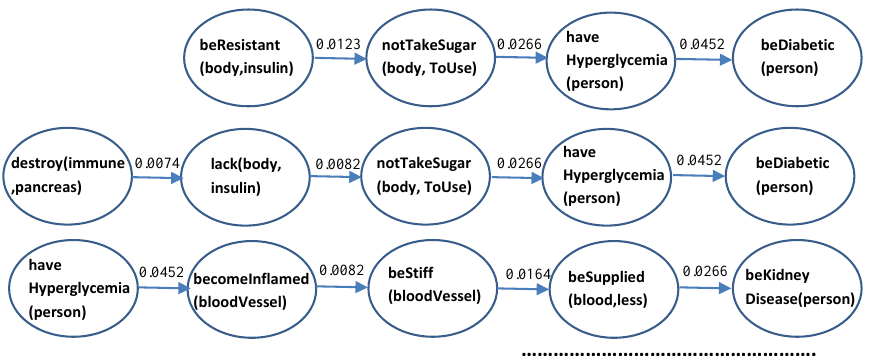
Figure 7. The representation of the correct extracted causal pathways with the explicit mediators of the diabetes and kidney disease group where the numeric label on each arrow represents the CErel probability of each CEpair by NB.